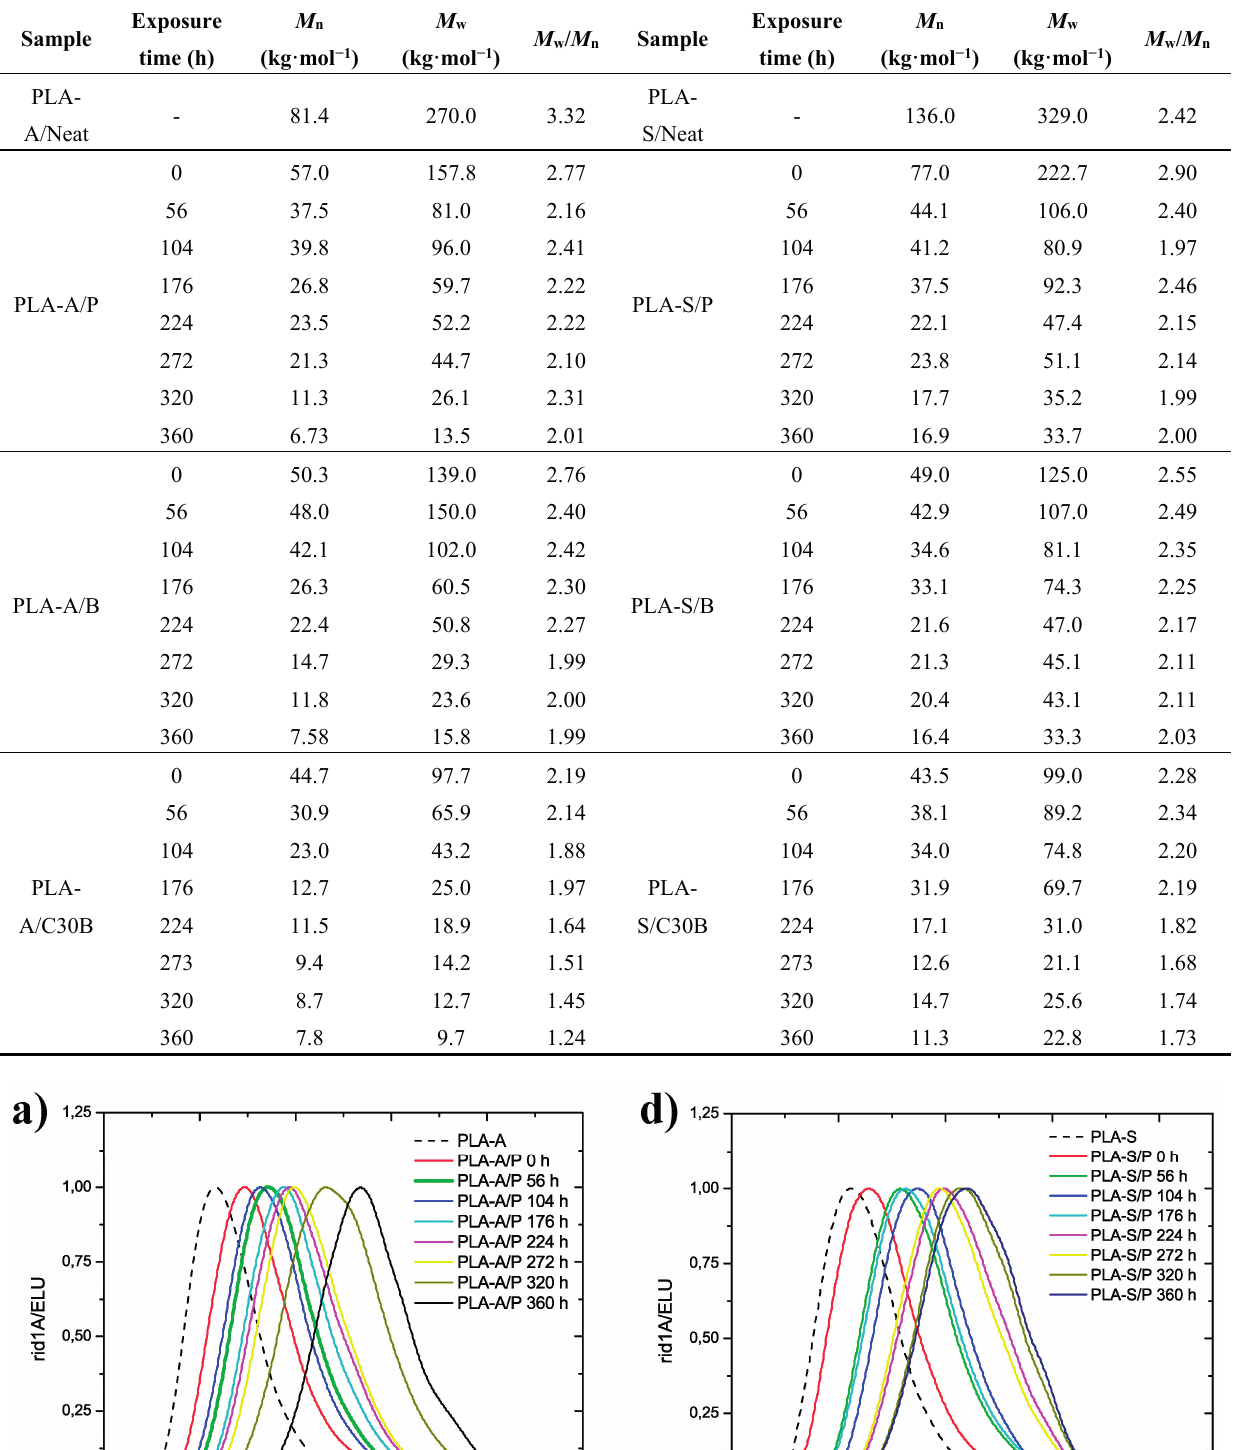
Table 2. MWD of degraded samples under artificial